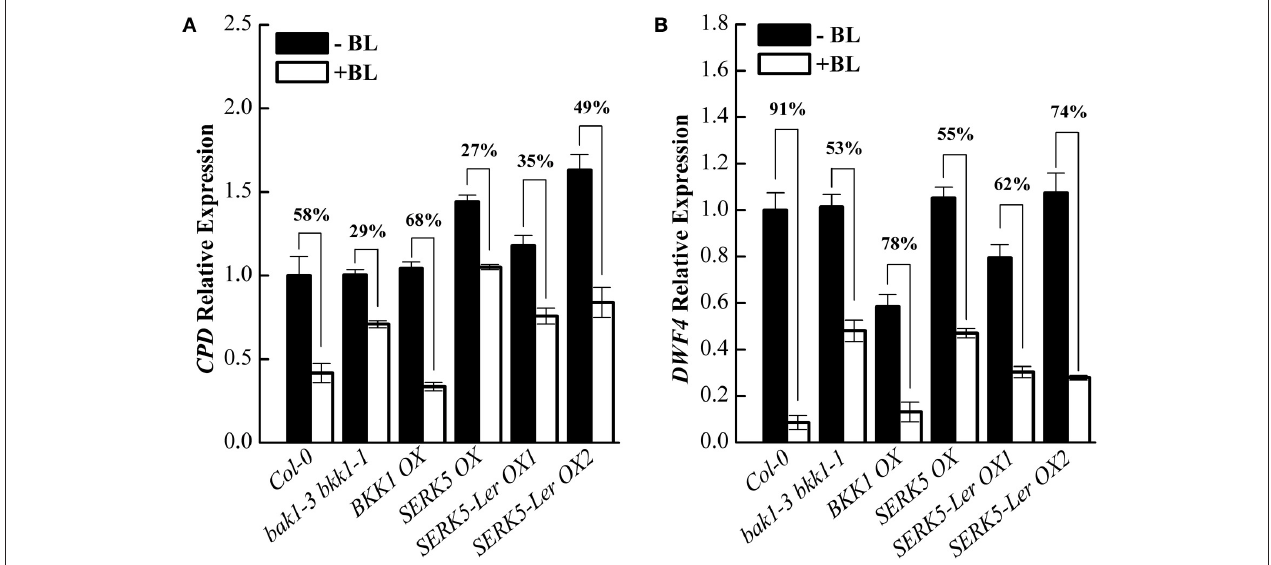
FIGURE 7 | Overexpression of SERK5 -L er partially restores BR signaling in bak1-3 bkk1-1. (A,B) 10-day-old seedlings which grown on 1/2 MS medium were treated with or without 1 µ M 24-epiBL for 3h. Relative expression level of CPD and D WF4 were measured by qRT-PCR. bak1-3 bkk1-1 partially restores the sensitivity of BR-responsive genes to BL treatment by overexpressing SERK5 -L er . ACTIN2 was used as the reference gene. Values are means ± SE ( n = 3 ). Experiments were repeated three times with similar results.